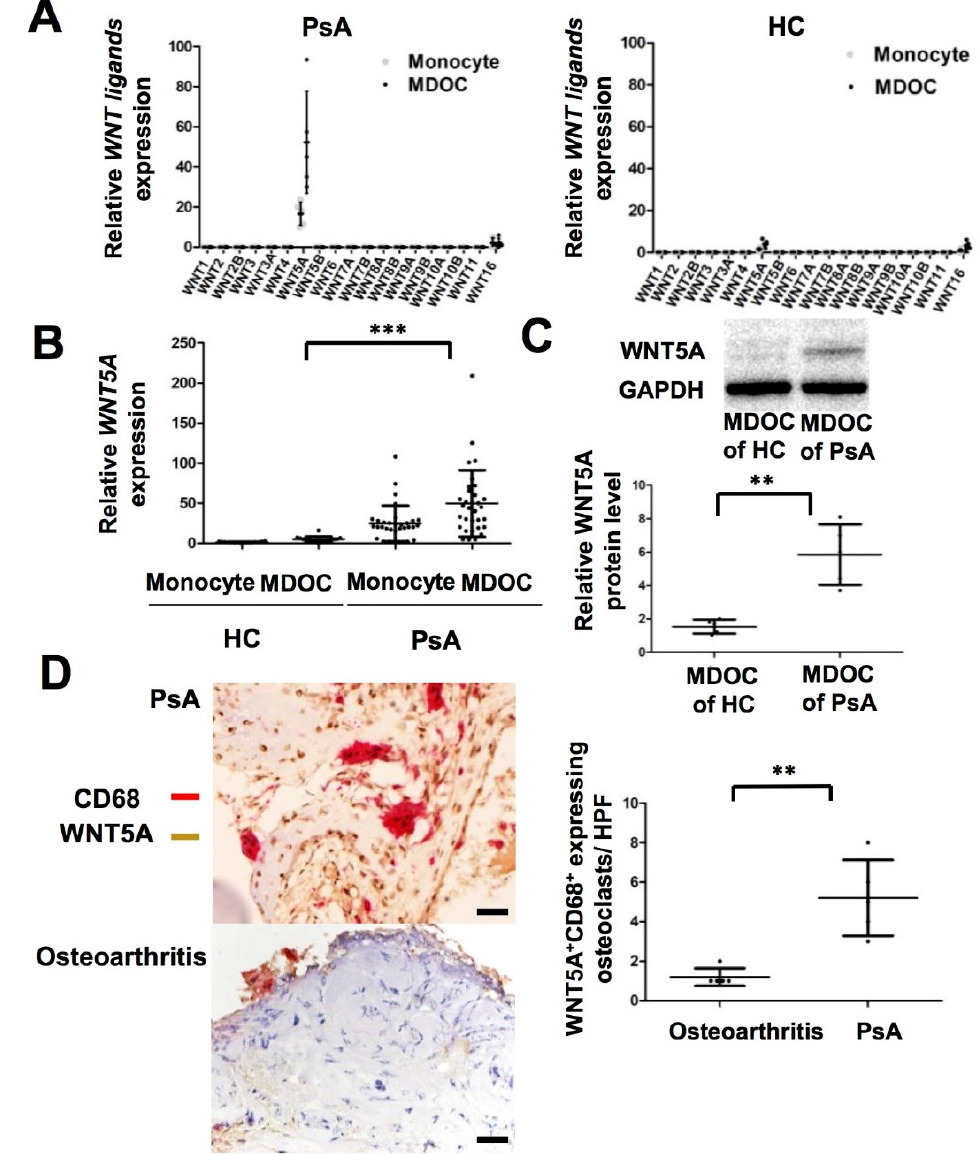
Figure 1. Increased expression of WNT5A in CD14 + monocyte-derived osteoclasts (MDOC) ex vivo and osteoclasts in destructive joints of PsA. ( A ) RNA samples from CD14 + monocytes and MDOC from healthy controls (HC) ( n = 5) and PsA patients ( n = 5) were analyzed to profile WNT expression using qRT-PCR. The WNT5A was selectively upregulated in MDOC from PsA patients compared to in those from HC. ( B ) The expression of WNT5A was measured by qRT-PCR in monocytes and MDOC from HC ( n = 16) and PsA patients ( n = 32). ( C ) The protein expression level of WNT5A in MDOC from PsA patients ( n = 5) and HC ( n = 5) was measured by Western blotting. The representative blot from MDOC of one HC and one PsA was shown. ( D ) One representative pair of specimens showed marked increased numbers of WNT5A + CD68 + expressing osteoclasts. Immunohistochemical analy- ses showed higher numbers of WNT5A (brown)-expressing and CD68 (red)-expressing osteoclasts in the destructive joints of patients with PsA ( n = 5) than in those from patients with osteoarthritis ( n = 5). Scale bar: 50 µ m. The error bar represents the standard deviation of each data set. ** indicates p < 0.01, and *** indicates p <